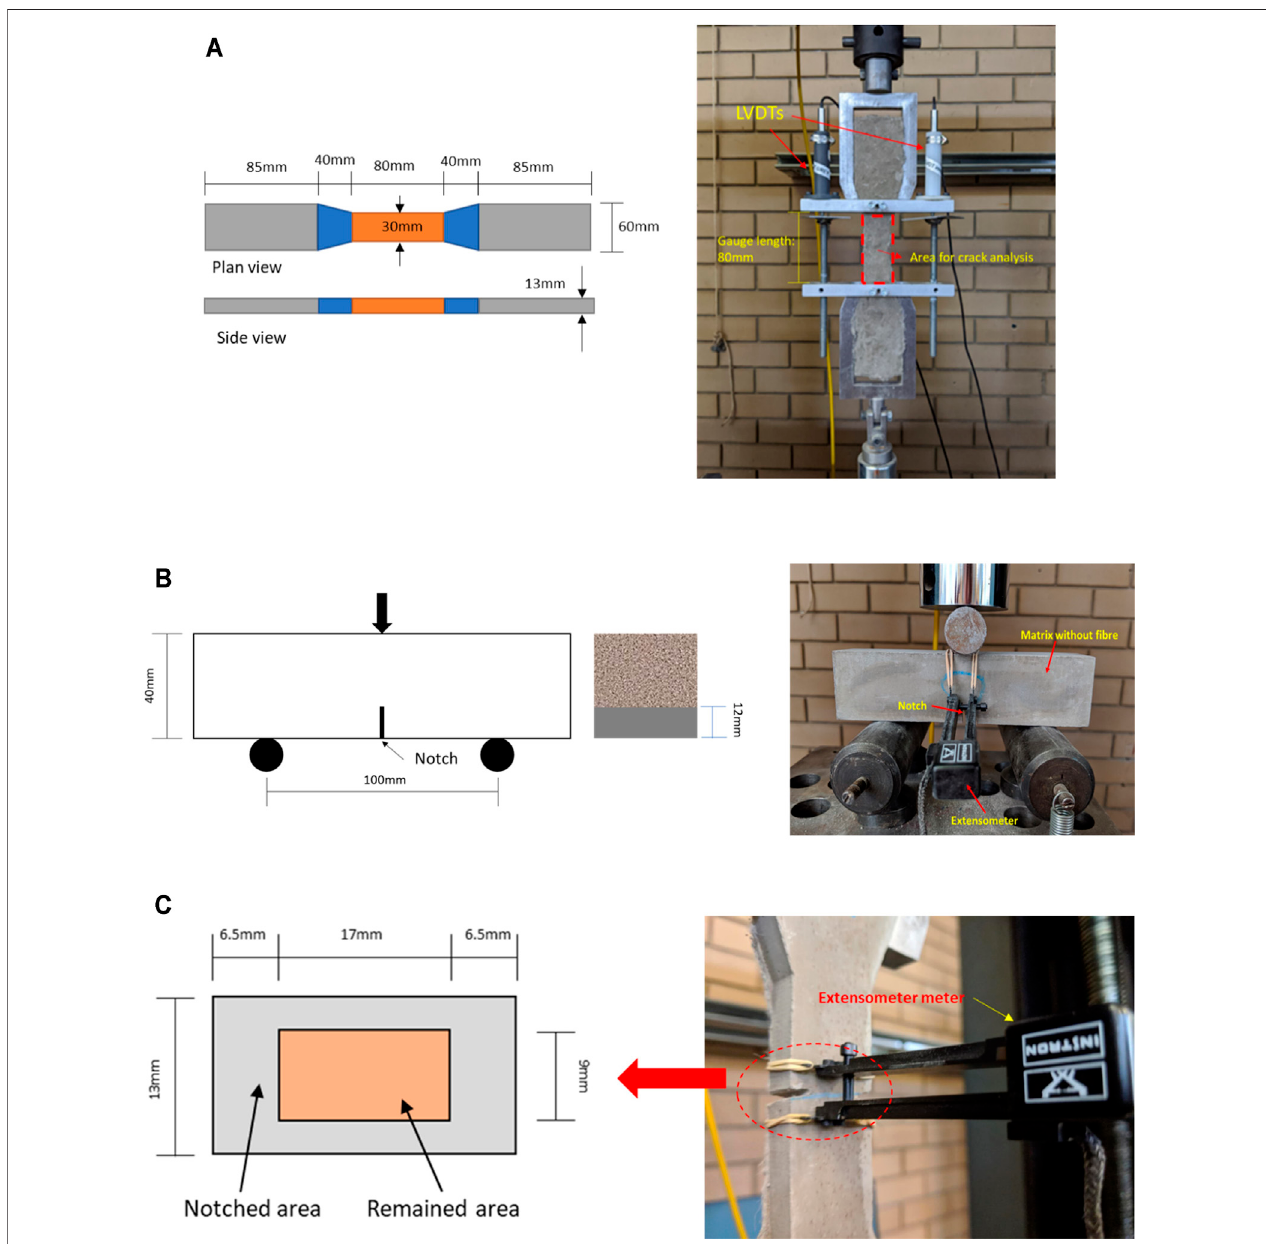
FIGURE 3 | (A) Direct tensile test setup: (B) Matrix toughness test setup; (C) Single crack tension test setup.